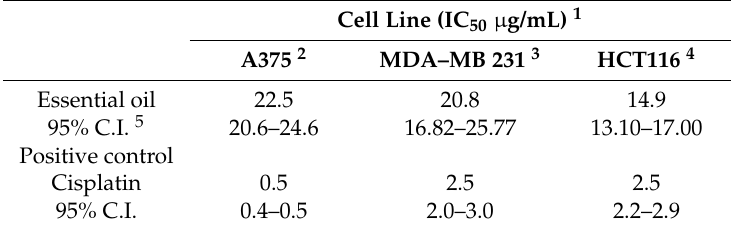
Table 2. In vitro growth inhibition of tumor cells by Erigeron floribundus essential oil.